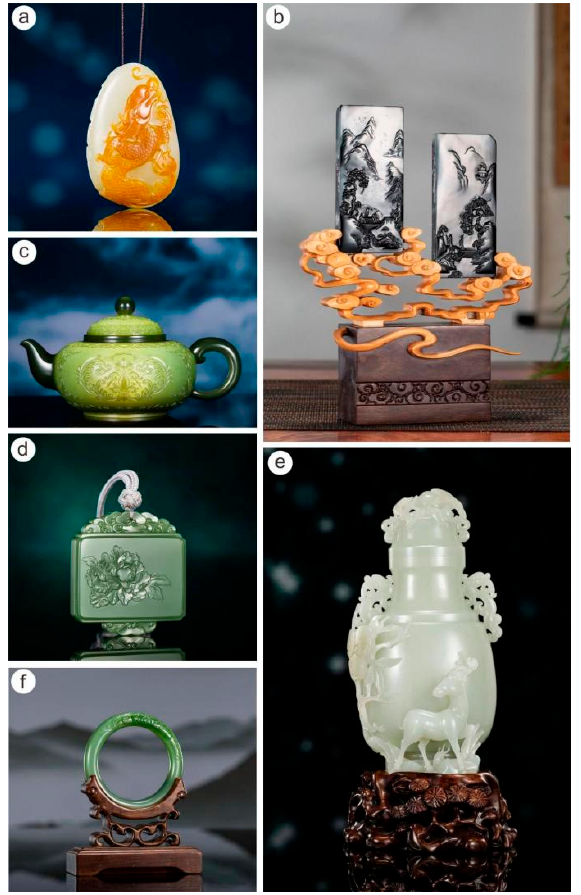
Figure 6. Representative nephrite jade carving photographs. ( a ) The white nephrite jade “Dragon” carving by Yongfang Wang from Hetian placer deposits, Xinjiang Province. ( b ) The black nephrite jade carving by Junhua Gao from Hetian placer deposits, Xinjiang Province. ( c ) The light green nephrite jade “teapot” carving by Yufeng Zhu. ( d ) The green nephrite jade carving by Yong Sun. ( e ) The white nephrite jade carving with extremely complex crafts by Yijin Gao. ( f ) The green nephrite jade bracelet by Chunbo Chen. (Photographs are provided by Beijing Boguan International Auctioneering Co., Ltd., Beijing, China).